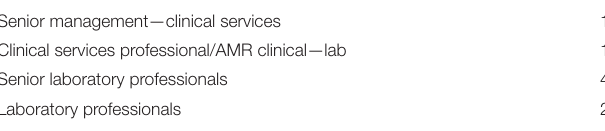
TABLE 2 | Job profile of